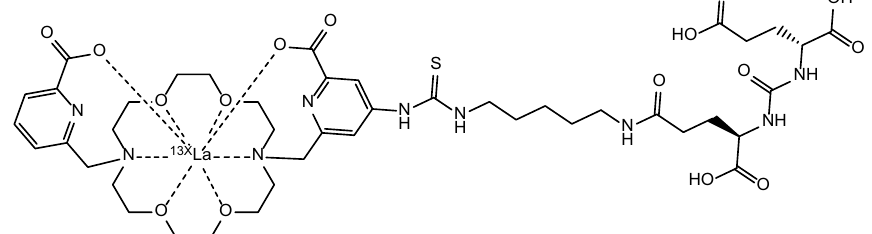
Fig. 5 Molecular structure of [ 13X La]La-macropa-DUPA, where X